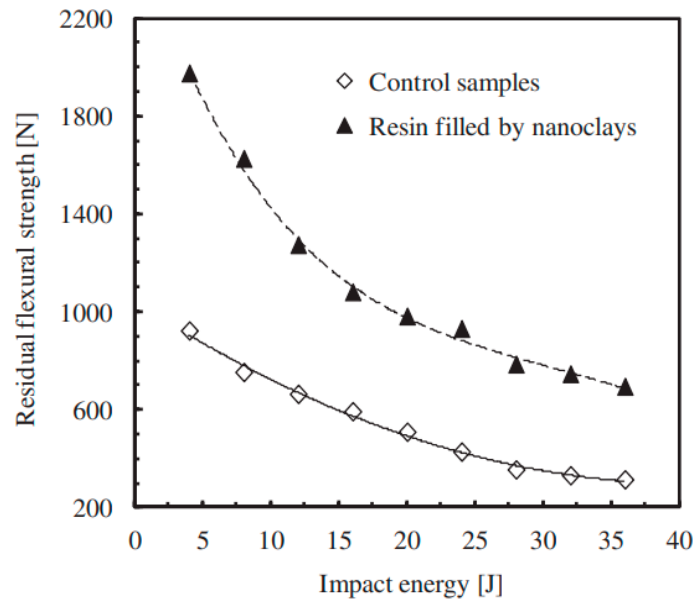
Figure 2. Residual flexural strength versus impact energy [12].